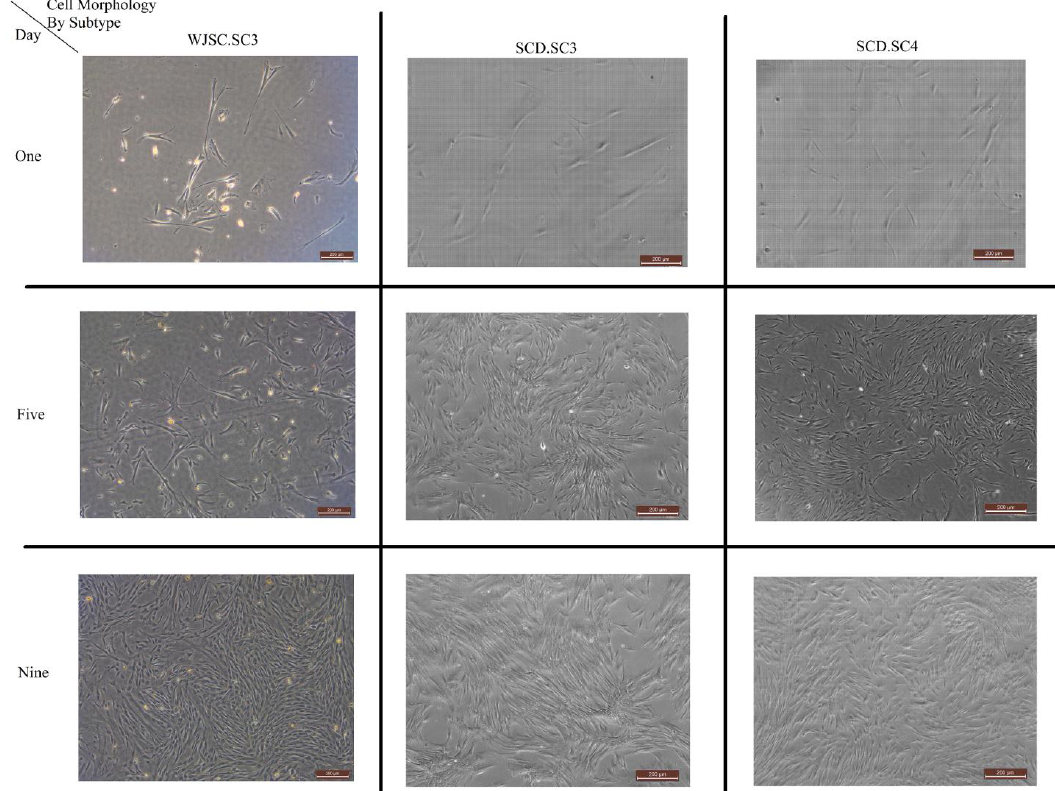
Figure 1. Morphology and the growth of the different MSCs obtained at different days of the experiment. The captured images provide a visual validation of the cell counts obtained in Table